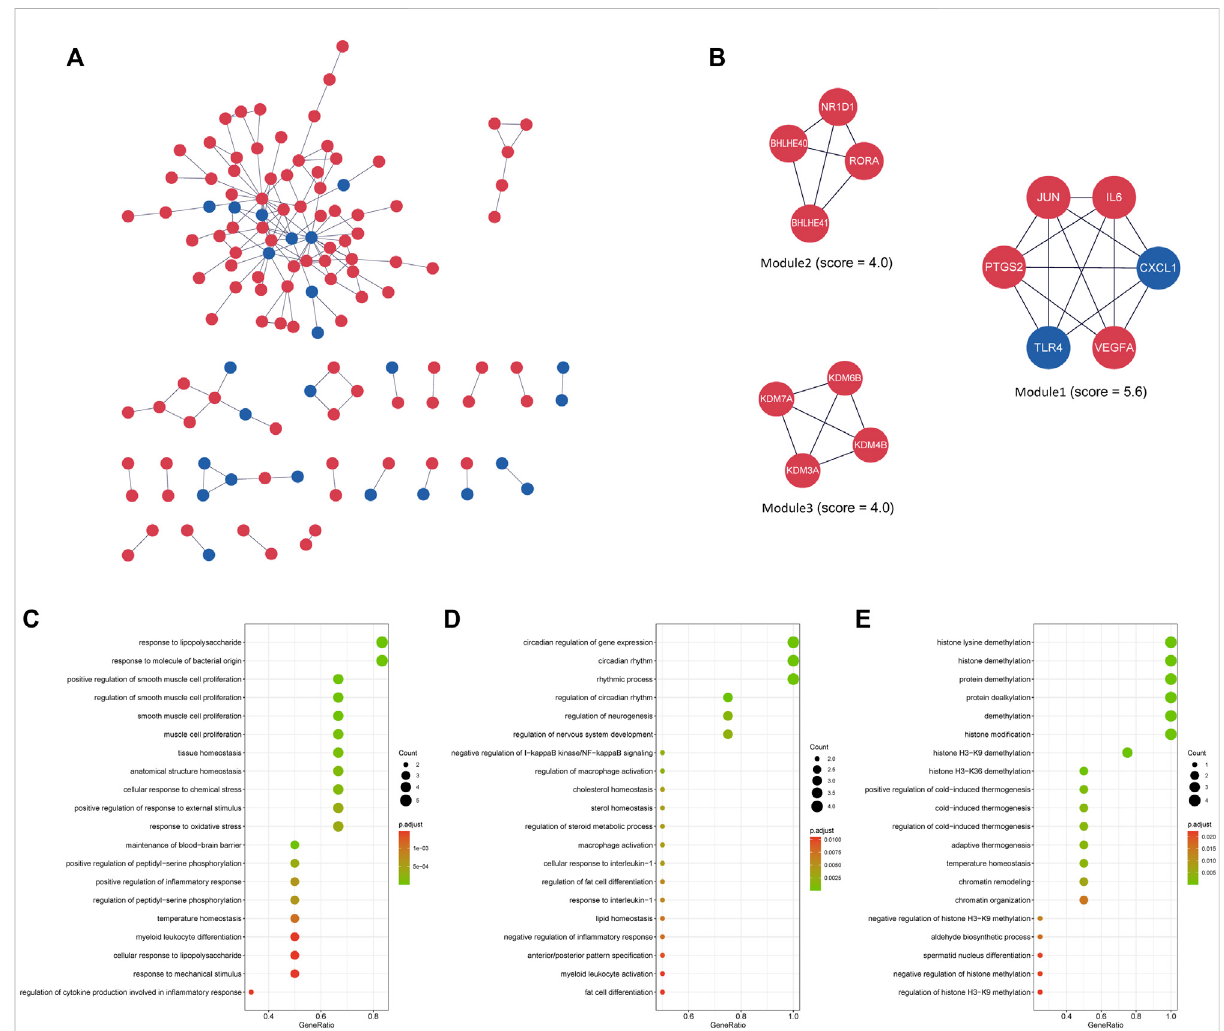
FIGURE 4 (A) The interaction network between proteins coded by DEGs comprised 125 nodes and 157 edges in the 4 h model. The red and blue circle nodesrepresentupregulatedanddownregulatedDEGs,respectively. (B) Threeclustermodulesextracted byMCODE. (C)